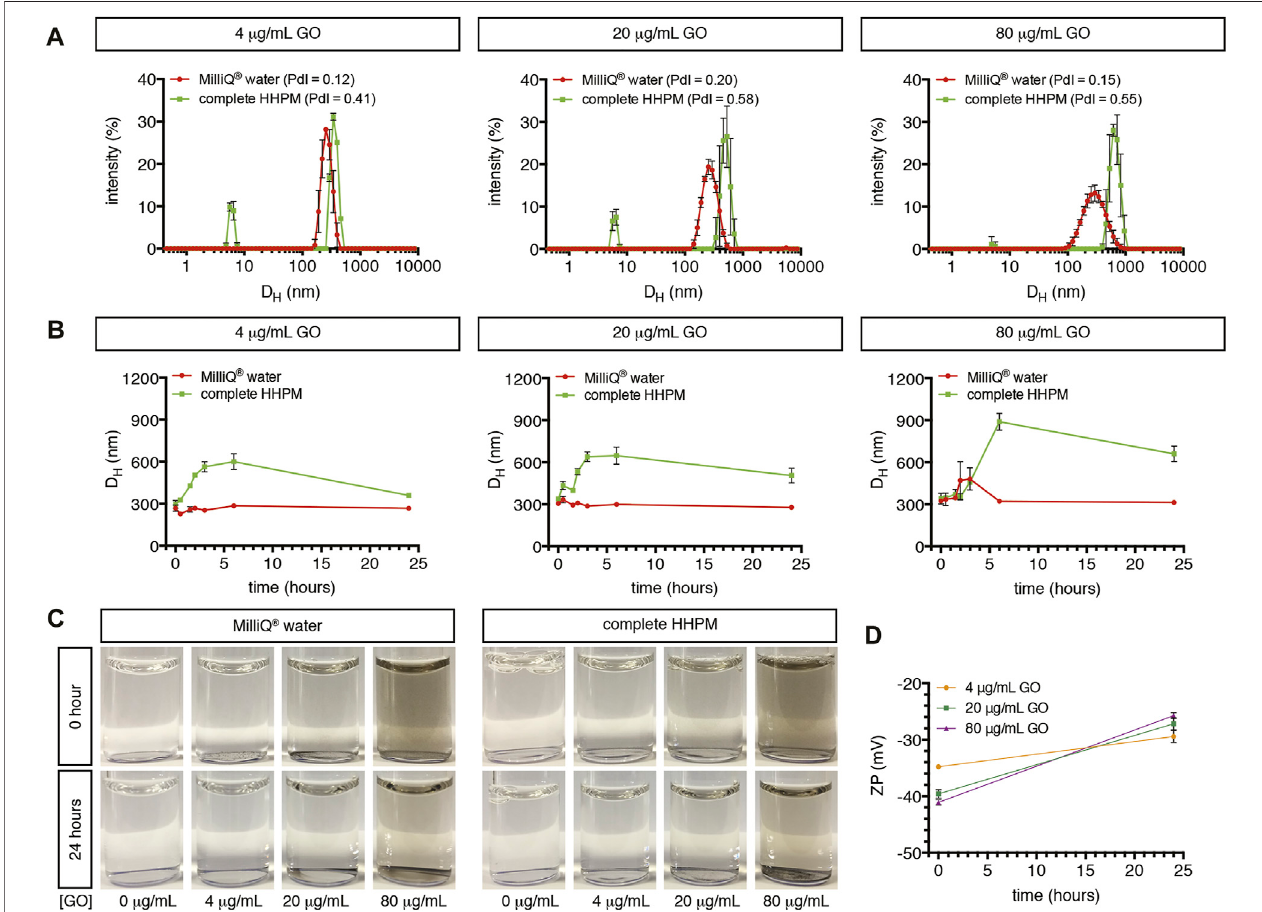
FIGURE 1 | Characterization of GO dispersed in Milli-Q ® water or complete HHPM. (A) Size distribution pro fi les by DLS analysis of GO dispersed in Milli-Q ® water (red curves) or complete HHPM for 24 h (green curves). Measurements refer to three GO concentrations. (B) Temporal stability of the main GO population when dispersed in Milli-Q ® water (red curves) or complete HHPM (green curves) at three concentrations over time (up to 24 h) assessed by DLS analysis. (C) Representative images of the GO stock suspension diluted in Milli-Q ® water and complete HHPM at three GO concentrations after 0 or 24 h of incubation, for visualizing